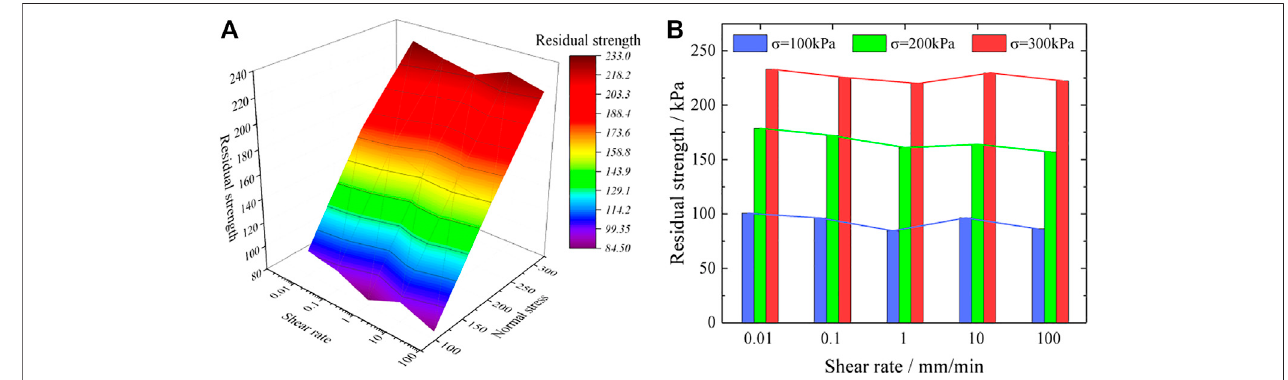
FIGURE 11 | The relationship between residual strength and shear rate. (A) Plot of residual strength versus shear rate and normal stress; (B) Plot of residual strength and shear rate.